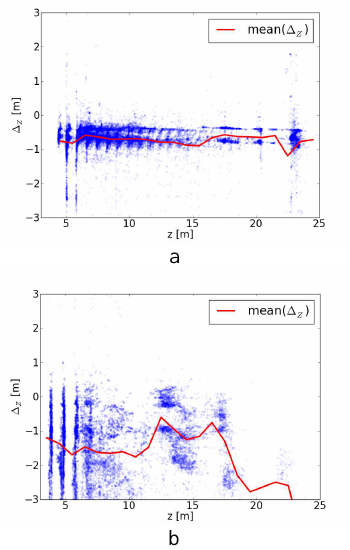
Figure 11. Density distribution (blue dotted) and mean (red solid) of depth z versus depth difference D z : a) PMD [vision] CamCube 2.0, b) Microsoft Kinect.